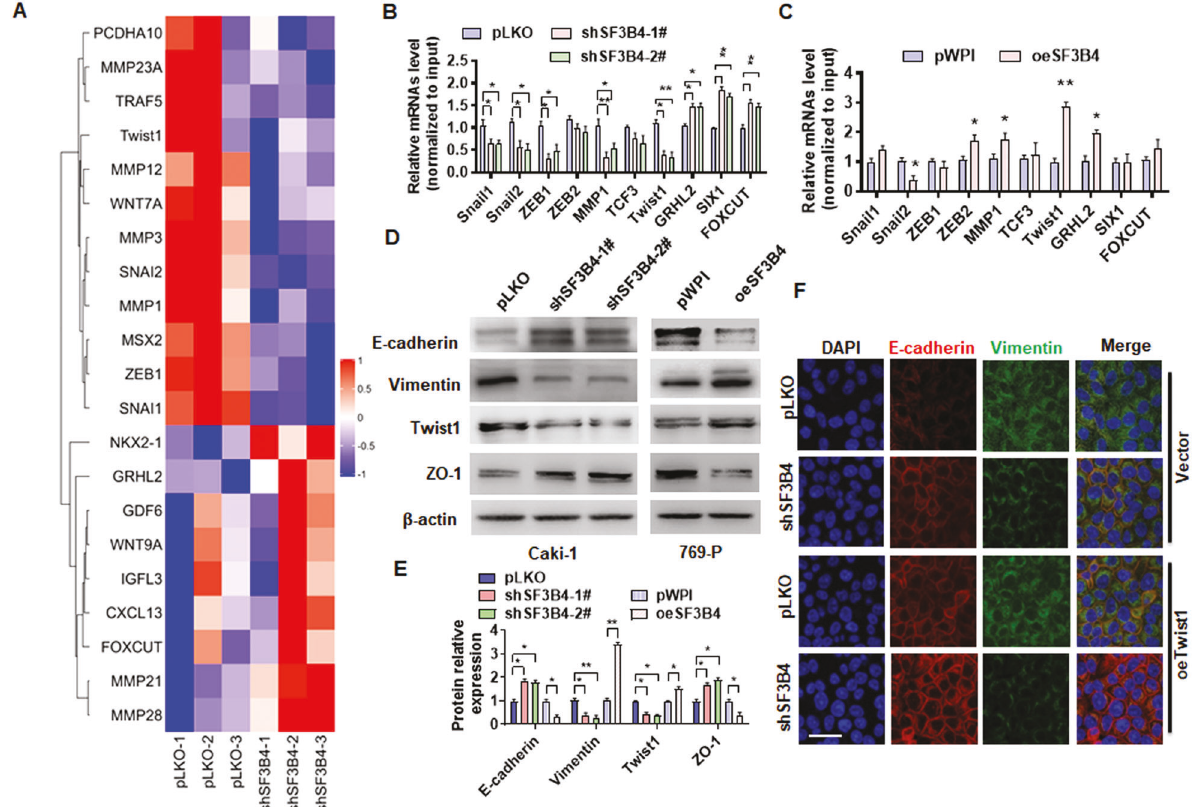
Fig. 3 Twist1 mediates SF3B4-induced EMT in ccRCC. A Gene expression pro fi les in pLKO or shSF3B4-transfected Caki-1 cells. Heat map of hierarchical clustering indicates the differentially expressed genes (red: upregulation; blue: downregulation). B , C Caki-1 ( B ) and 769-P ( C ) cells were transfected with shSF3B4 or oeSF3B4, and then RT-qPCR detected the expression of the indicated genes. D The expressions of EMT- related genes, E-cadherin, vimentin, Twist1, and ZO-1 were detected by western blot in shSF3B4-transfected Caki-1 or oeSF3B4-transfected 769-P cells. E Quantitative analysis of D . F Caki cells were transfected with shSF3B4 or oeTeist1 or control vector, alone or together, and the expression of E-cadherin and vimentin were detected by double immuno fl uorescence staining. Scale bar = 20 μ m. All data are expressed as the mean ± SEM of three independent experiments. * P < 0.05, ** P < 0.01 vs. their corresponding